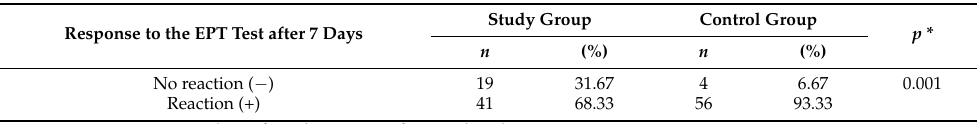
Table 4. Comparison of the response of second molars of the study group and the control group to electrical test 7 days after treatment.